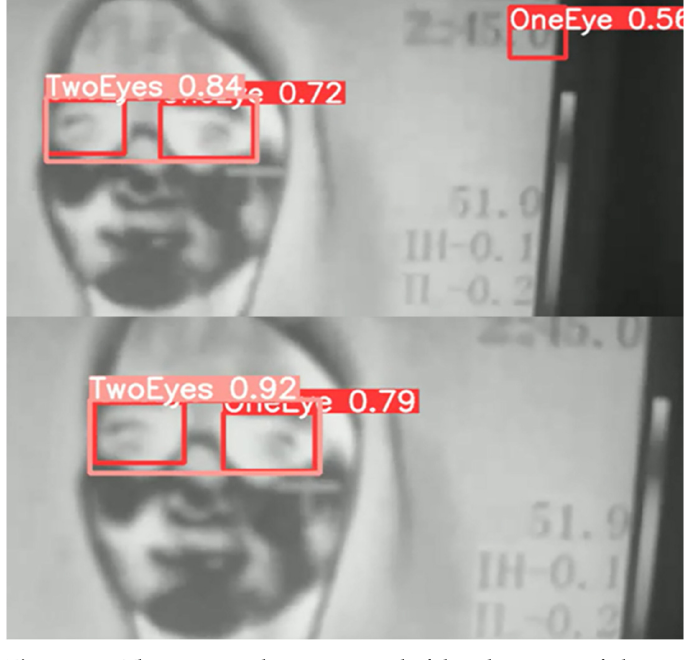
Figure 14. The same video scene with false detection of the one eye class by YOLOv5n, which YOLOv5s does not detect. IoU scores are displayed (Pink boxes are for Two Eyes detection and red boxes are for One Eye detection).